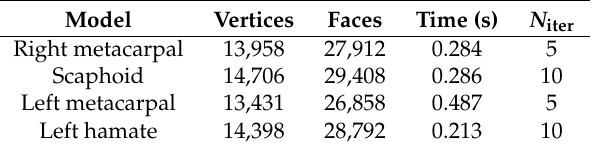
Table 2. Runtime (in seconds) per iteration and number of iterations used for denoising different models. Model Vertices